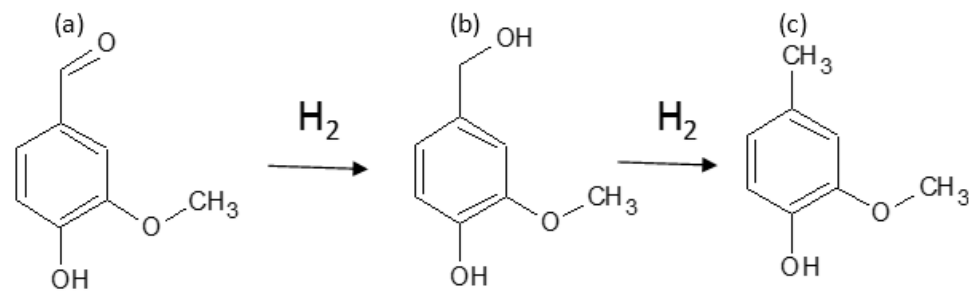
Figure 12. Reaction scheme for HDO of vanillin under 10 bar hydrogen in water at 70–150 °C over Pd/TiO 2 adapted from reference [29]. Notation ( a ) vanillin; ( b ) 4 ‐ hydroxymethyl ‐ 2 ‐ methoxyphenol and ( c ) 2 ‐ methoxy ‐ 4 ‐ methylphenol.